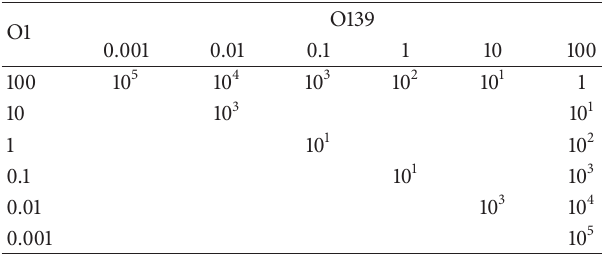
Table 2: The unequally reciprocal detection of V . cholerae O1: O139 by the O serogroup-specific TMPCR.